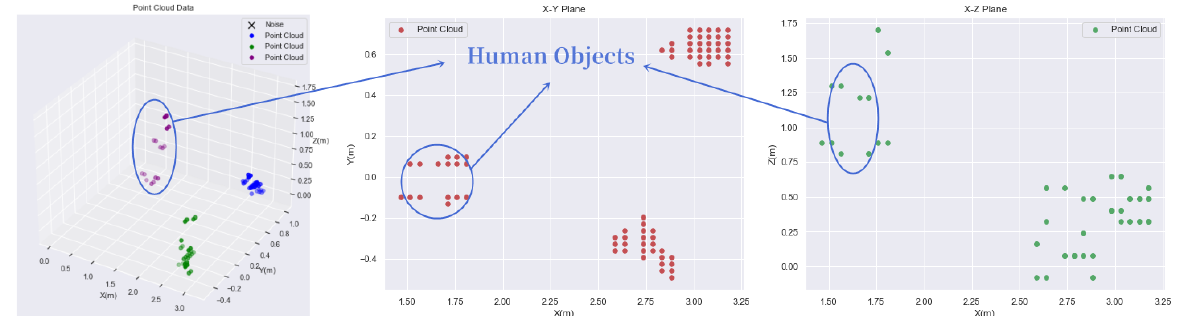
Figure 2. 2D and 3D projections of the point cloud. The point corresponding to three human objects are compact in the horizontal X–Y plane but dispersed in the vertical X–Z